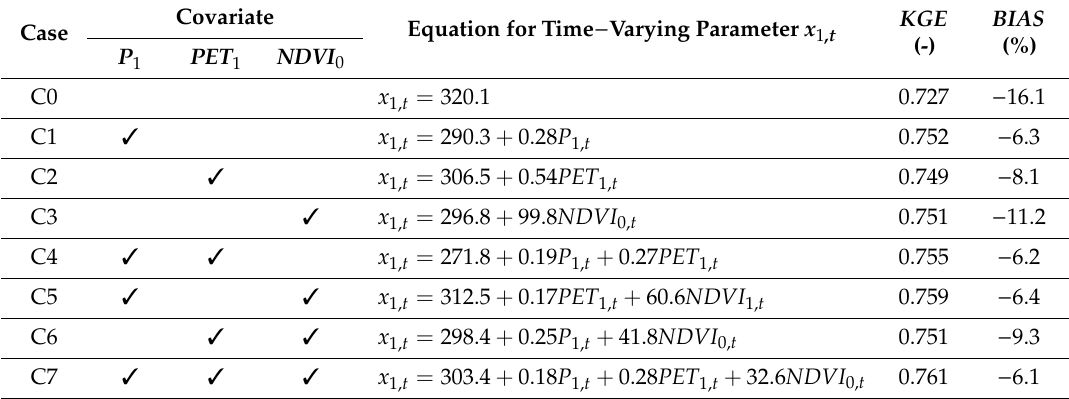
Table 4. Comparison of streamflow simulation performance of the GR4J model (C0) and the GR4J-T model (C1–C7) in Weihe Basin during the sub-period 1 (SP1, from 1981 to 1985).